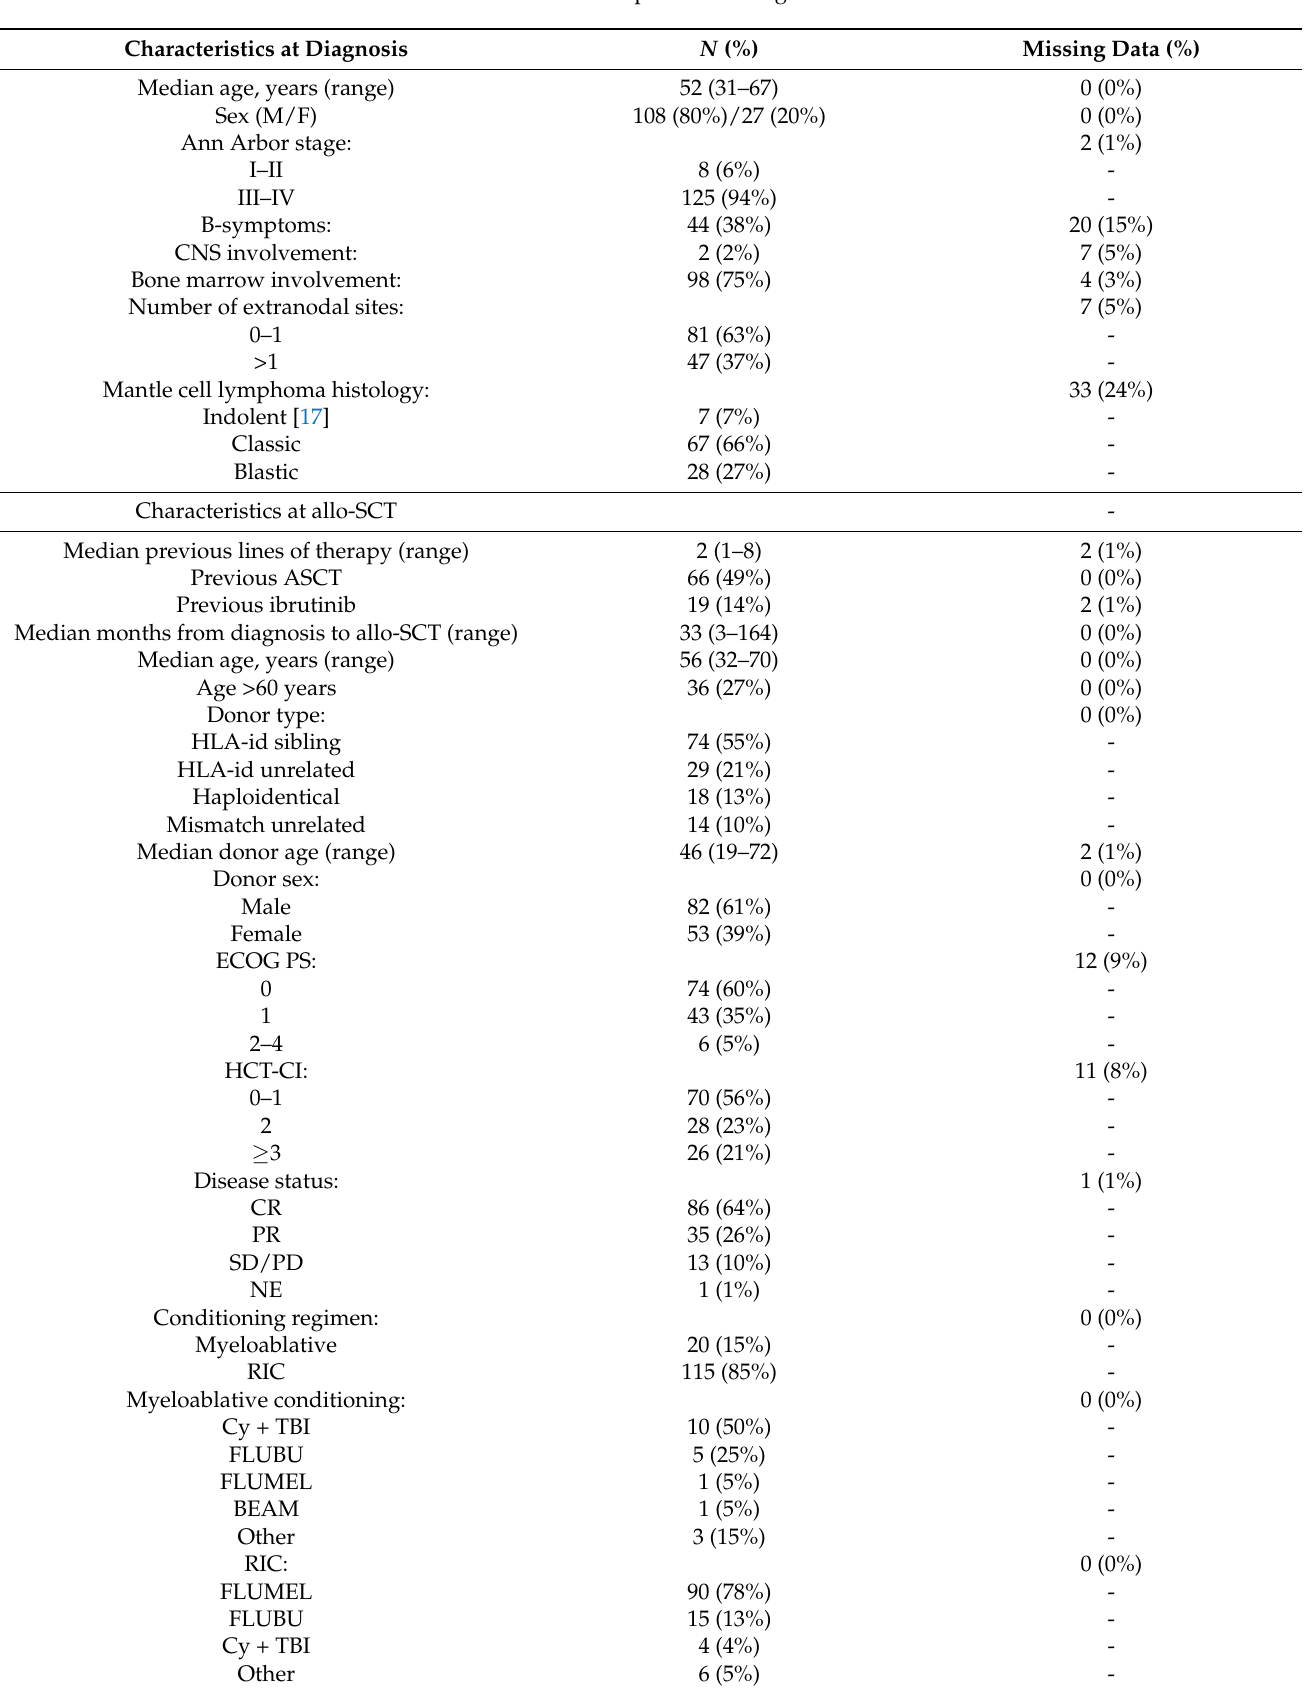
Table 1. Main characteristics of patients at diagnostic and before